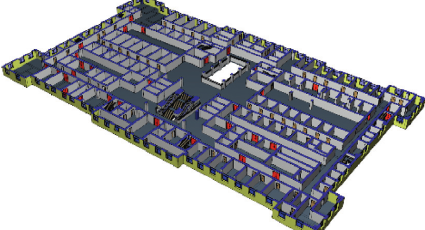
Figure 24: Hall actual picture of floor